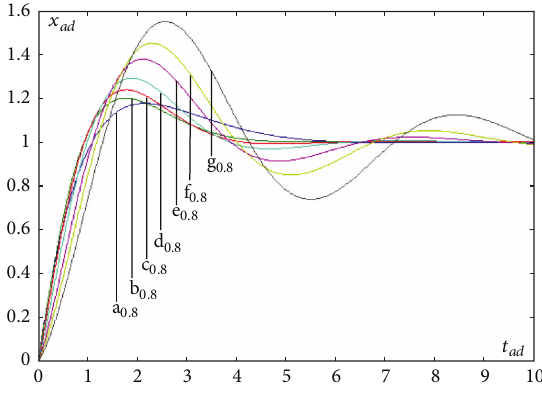
Figure 9: 𝑥 𝑎𝑑 as function of 𝑡 𝑎𝑑 , parameter sets of Table